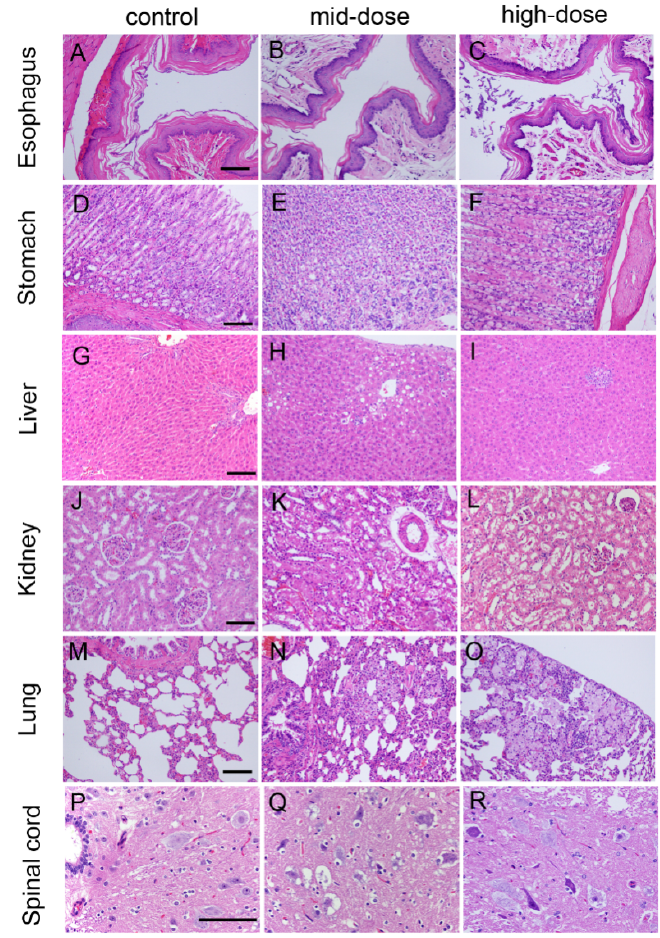
Figure 3. Hematoxylin and eosin-stained histologic sections of rat esophagus ( A – C ); stomach ( D – F ); liver ( G – I ); kidney ( J – L ); lung ( M – O ); and spinal cord ( P – R ). Note: ( A ) Esophagus from control rat; ( B ) esophagus from mid-dose rat; ( C ) esophagus from high-dose rat; ( D ) stomach from control rat; ( E ) stomach from mid-dose rat; ( F ) stomach from high-dose rat; ( G ) liver from control rat; ( H ) liver from mid-dose rat; ( I ) liver from high-dose rat; ( J ) kidney from control rat; ( K ) kidney from mid-dose rat; ( L ) kidney from high-dose rat; ( M ) lung from control rat; ( N ) lung from mid-dose rat; ( O ) lung from high-dose rat; ( P ) spinal cord from control rat; ( Q ) spinal cord from mid-dose rat; and( R ) spinal cord from high-dose rat. Scale bar: 25 μ m.